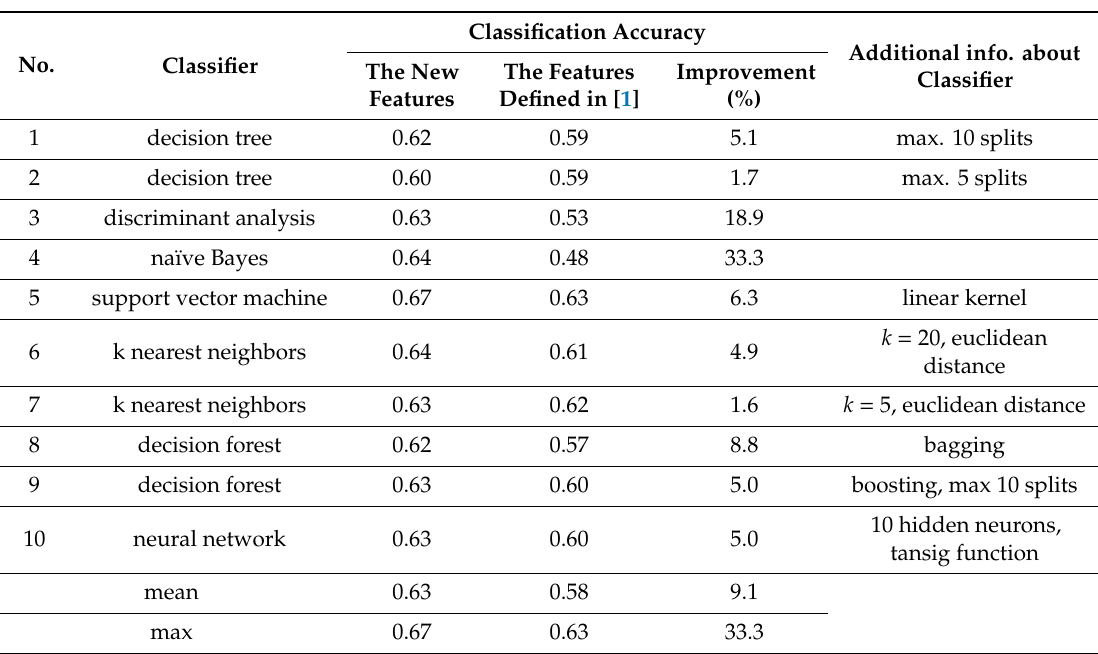
Table 4. Comparison between classification accuracies for the new features and the features defined ( classification _ accuracy OLD − classification _ accuracy NEW ) · in [1]. The improvement is calculated as classification _ accuracy OLD